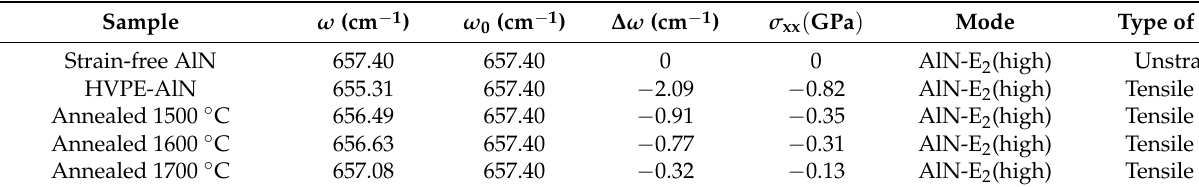
Table 1. Stress modes in four groups of AlN samples.